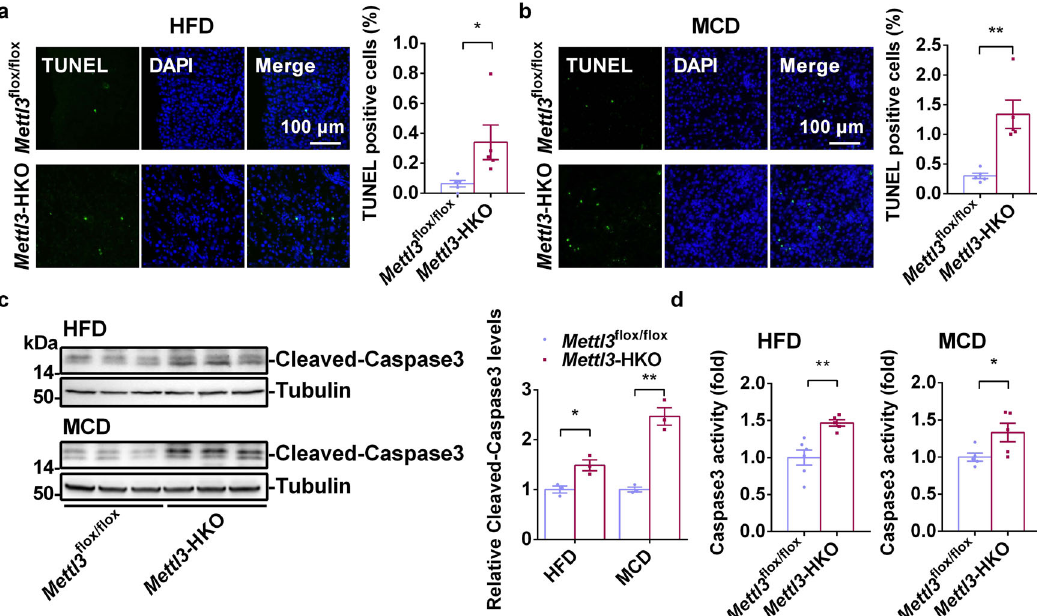
Fig. 4 Liver-speci fi c Knockout of Mettl3 accelerates diet-induced liver injury. a The TUNEL-positive cells in Mettl3 fl ox/ fl ox and Mettl3- HKO mice fed an HFD for 12 weeks ( n = 5 for each group; P = 0.0474). b The TUNEL-positive cells in Mettl3 fl ox/ fl ox and Mettl3- HKO mice fed an MCD for 3 weeks ( n = 5 for each group; P = 0.0027). c Cleaved caspase3 levels were measured by immunoblotting in the livers of Mettl3 fl ox/ fl ox and Mettl3- HKO mice fed either an HFD or MCD. Cleaved caspase3 levels were quanti fi ed by ImageJ and normalized to Tubulin ( n = 3 for each group; HFD, Mettl3 fl ox/ fl ox versus Mettl3-